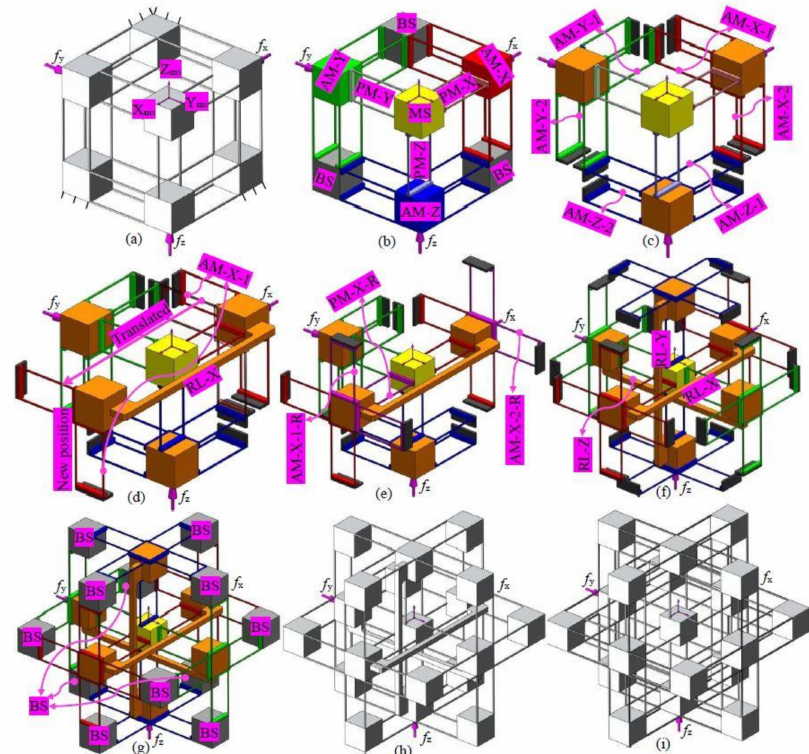
Figure 3. A symmetric XYZ compliant parallel mechanism (CPM) obtained via reconfiguring a non-symmetric XYZ CPM: ( a ) the original non-symmetric XYZ CPM [29]; ( b ) decomposition of the non-symmetric XYZ CPM; ( c ) further decomposition of the actuated compliant modules (AMs) of the non-symmetric XYZ CPM; ( d ) AM-X-1 translated to a new permitted position; ( e ) addition of redundant compliant modules (over-constraints); ( f ) reconfiguration of the legs associated with the translations along the Y ms - and Z ms -axes; ( g ) BS design; ( h ) resulting symmetric XYZ CPM; and ( i ) symmetric XYZ CPM designed by traditional approach, i.e., directly adding redundant compliant